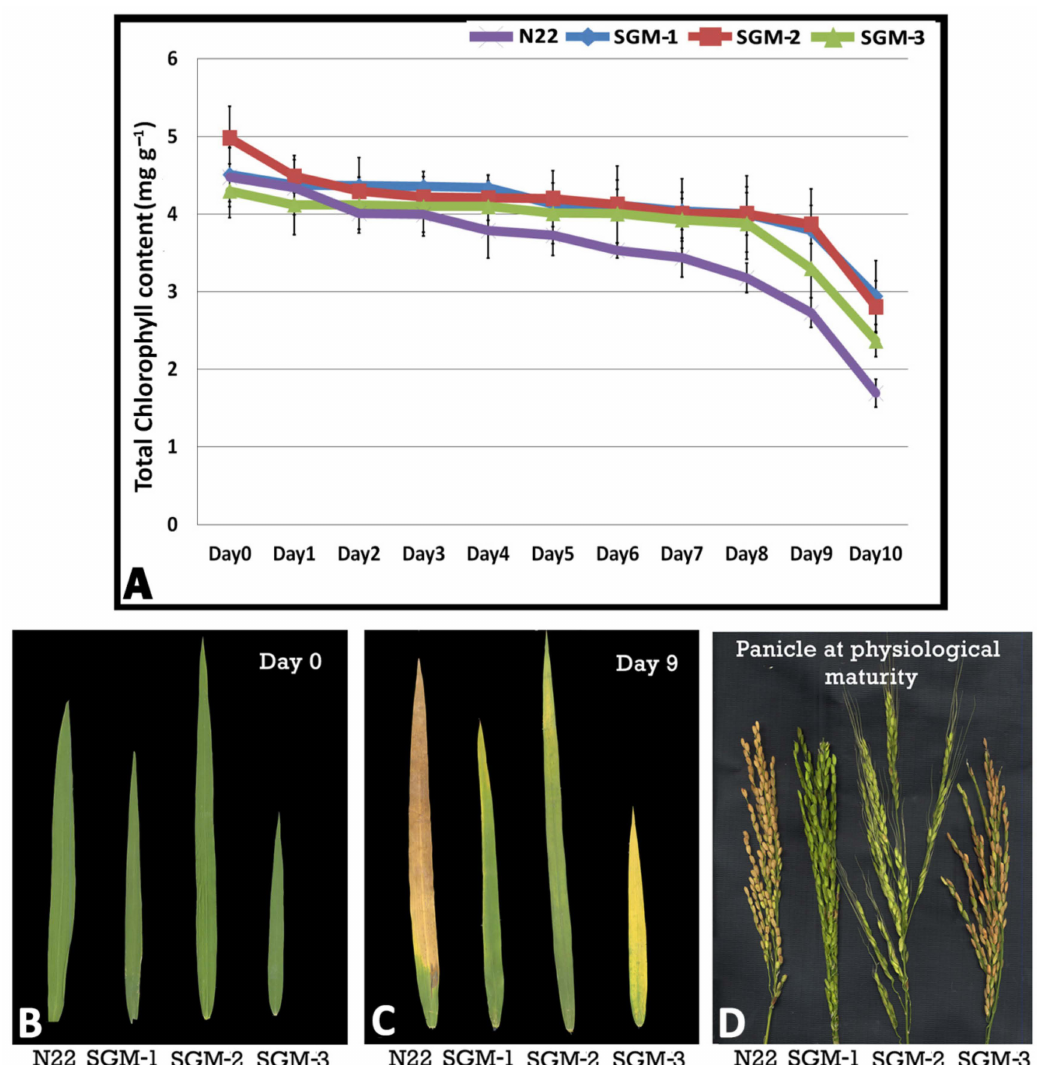
Figure 1. Senescence in the three stay-green mutants (SGM-1 to SGM-3) and the wild type, Nagina 22 (N22). ( A ) Total chlorophyll content in the flag leaf of the mutants and N22 under dark induced senescence from day 0 to day 10; ( B ) flag leaf images of the mutants and N22 on day 0; ( C ) flag leaf images of the mutants and N22 on day 10; ( D ) panicles of the mutants and N22 at physiological